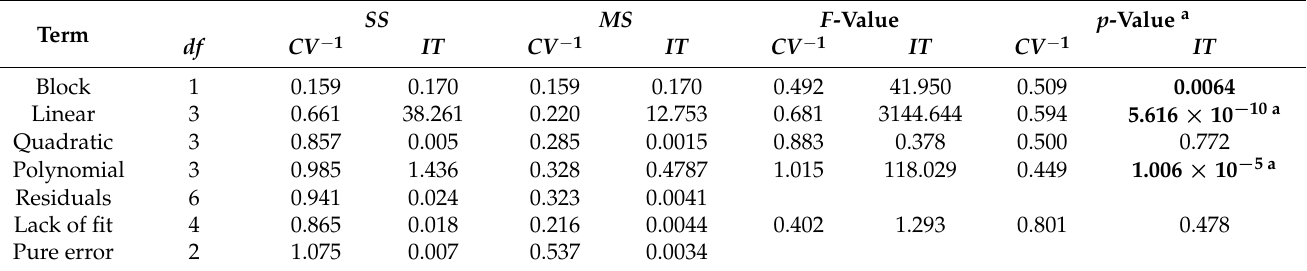
Table 3. ANOVA table for the inverse of coefficient of variation ( CV − 1 ), induction time ( IT ), and non-linear response models.